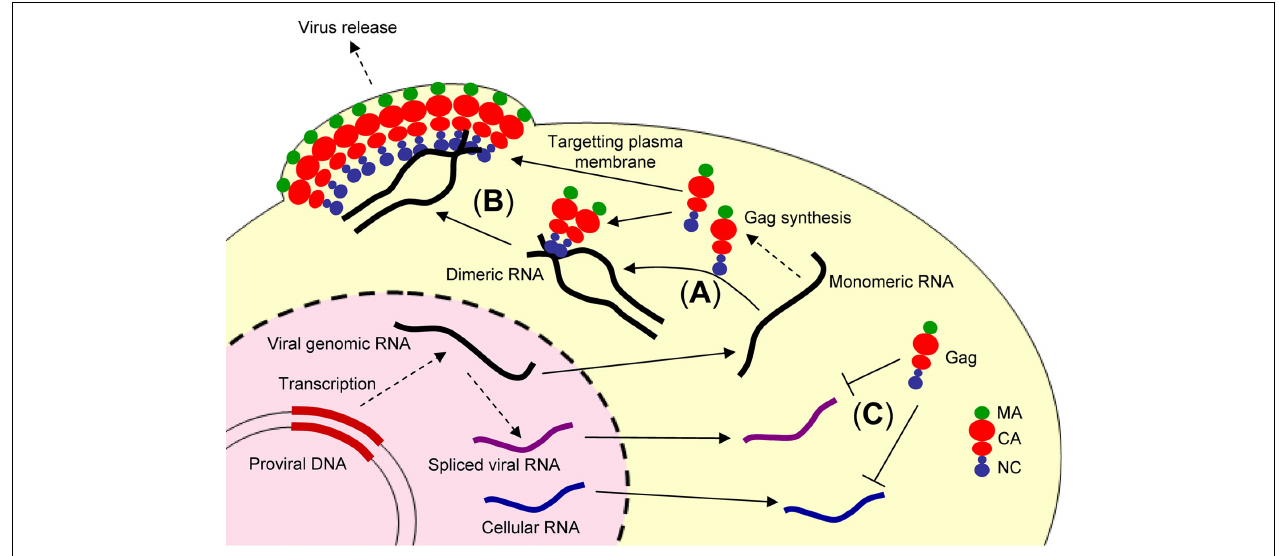
RNA complex is transported to the plasma membrane, where further assembly and budding occur, mediated by the myristoylated MA domain of Gag. (C) In contrast, spliced viral RNA or cellular RNA is not bound to the NC domain of Gag or may be bound to a small number of Gag polyproteins insufficient for trafficking to the plasma